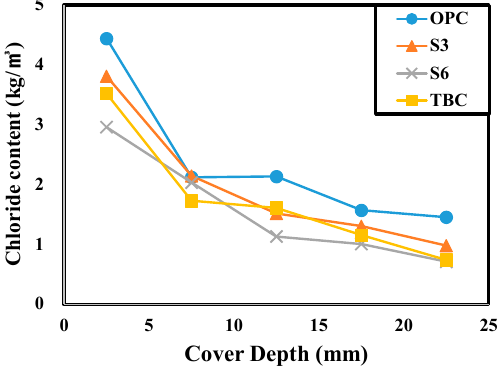
Figure 11. Variation of chloride content according to cover depth.